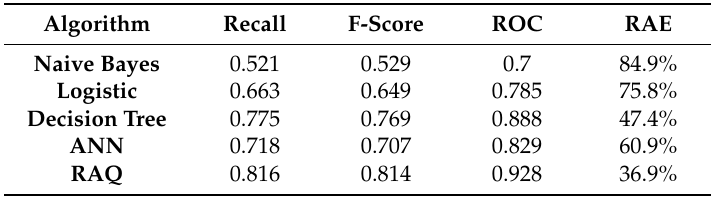
Table 7. Indexes of different algorithms.